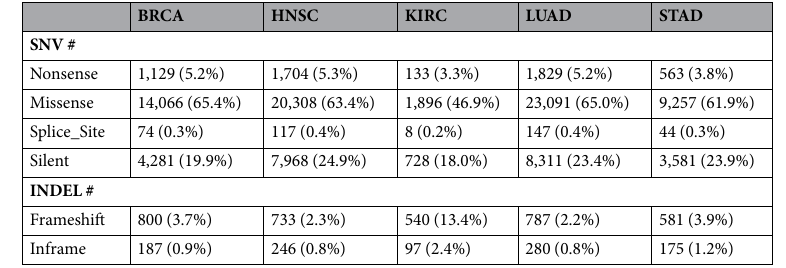
Table 1. Number of mutations across five tumor